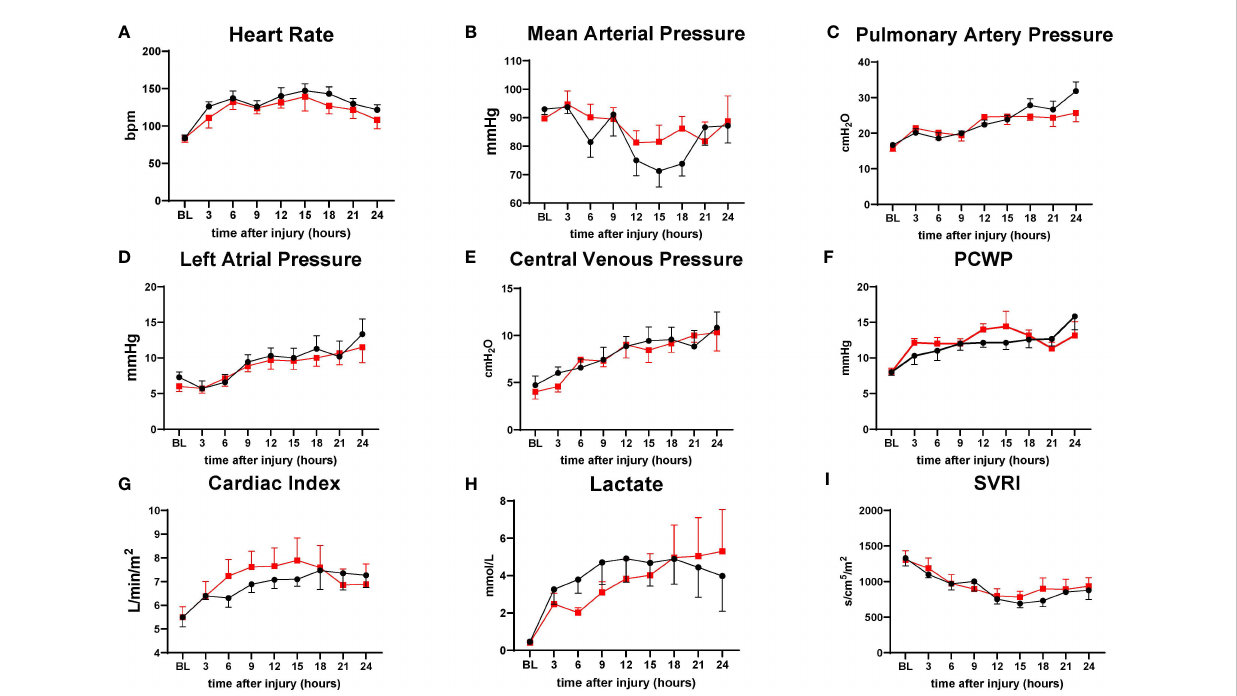
FIGURE 3 The severity of lung injury. ● Control (n=7 at 0-18 h and 6 at 19-24 h), ■ Treatment (n=7 at 0-16 h and 6 at 17-24 h). There were no differences in hemodynamic changes. Heart rate (HR) (A) , mean arterial pressure (MAP) (B) , pulmonary artery pressure (PAP) (C) , left atrial pressure (LAP) (D) , central venous pressure (CVP) (E) , pulmonary capillary wedge pressure (PCWP) (F) , cardiac index (CI) (G) , lactate (H) , systemic vascular resistance index (SVRI) (I) . Data are expressed as mean ± SEM.